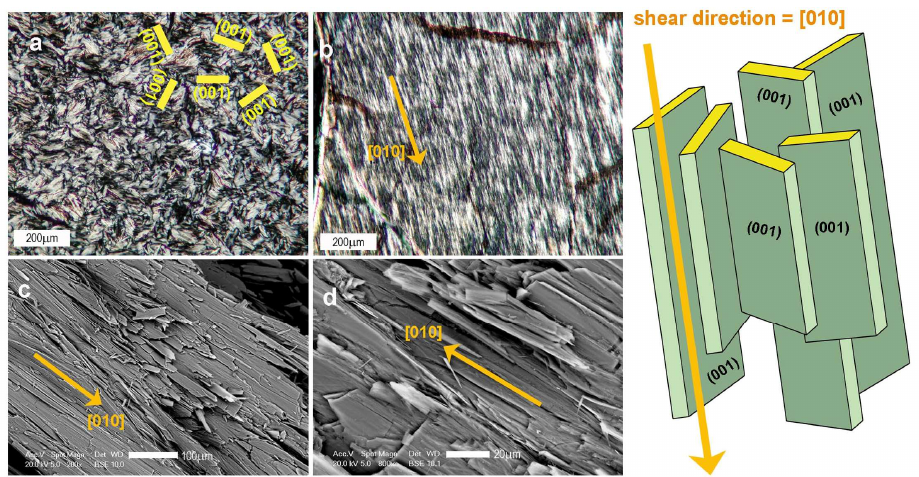
Figure 8. Splintery antigorite veins. (a and b) Polarised light images (crossed nicols) taken orthogonal ( a ) and parallel ( b ) to the splinter elongation direction. ( c , d ) BSE/SEM images of splintery antigorite veins; orange arrows indicate shear direction and correspond to antigorite [010]. The cartoon shows the shape and the crystallographic orientation of antigorite crystals in splintery veins, with [010] axes broadly parallel to the shear direction. In this orientation, the (001) planes of antigorite are randomly oriented around [010], but are parallel to the shear direction, potentially favouring strain-induced (001) sliding.